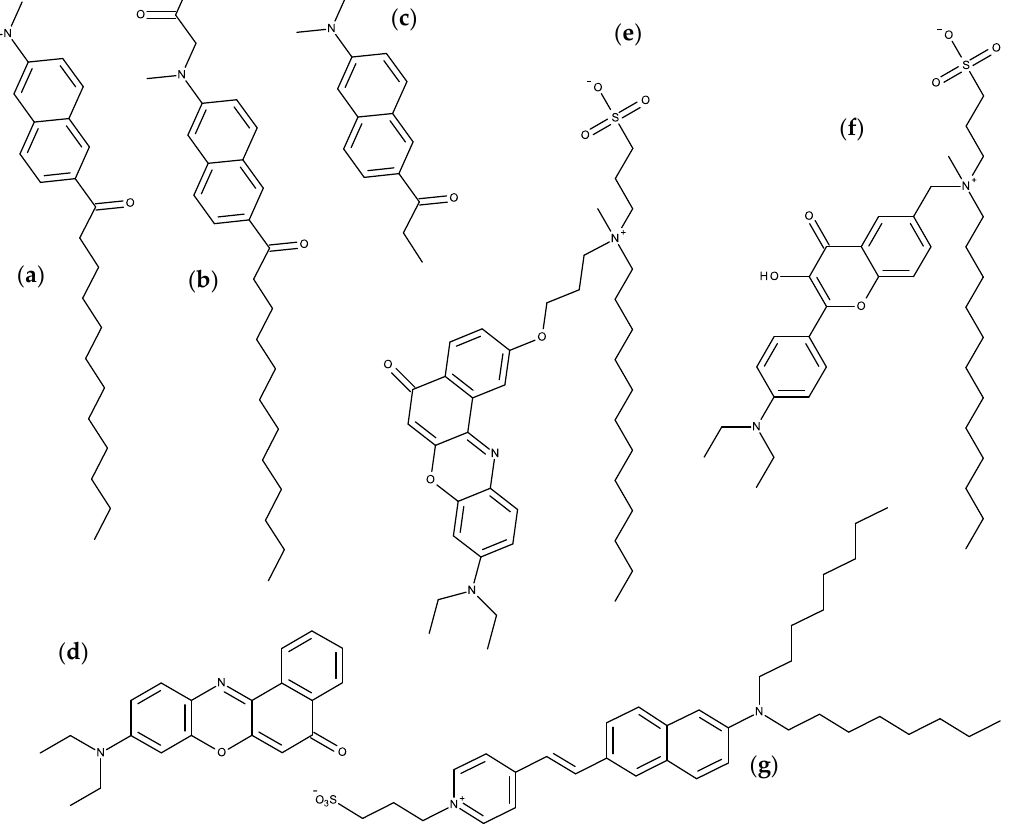
Figure 6. Structures of environment-sensitive probes. ( a ) Laurdan; ( b ) c-Laurdan; ( c ) Prodan; ( d ) Nile red; ( e ) NR12S; ( f ) F2N12S; ( g ) di-8-ANNEPS.